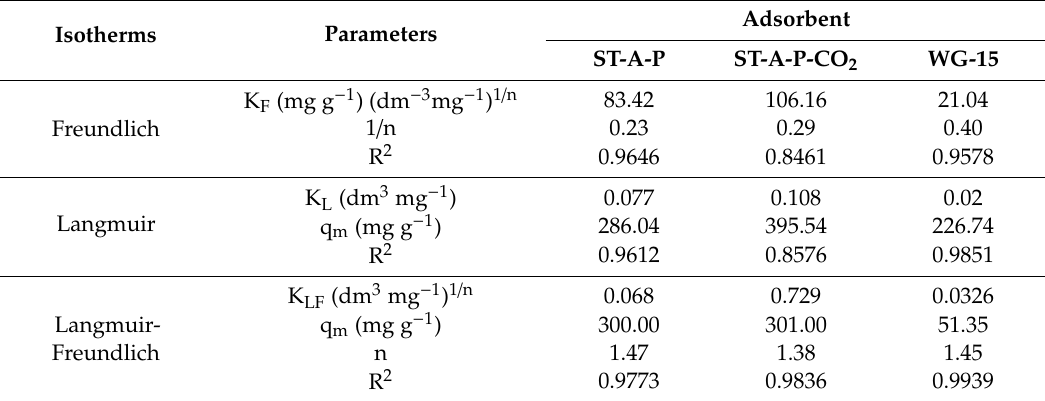
Table 9. Langmuir, Freundlich, and Langmuir-Freundlich equations parameters and correlation coe ffi cients R 2 for the adsorption of naproxen on the studied adsorbents. Isotherms